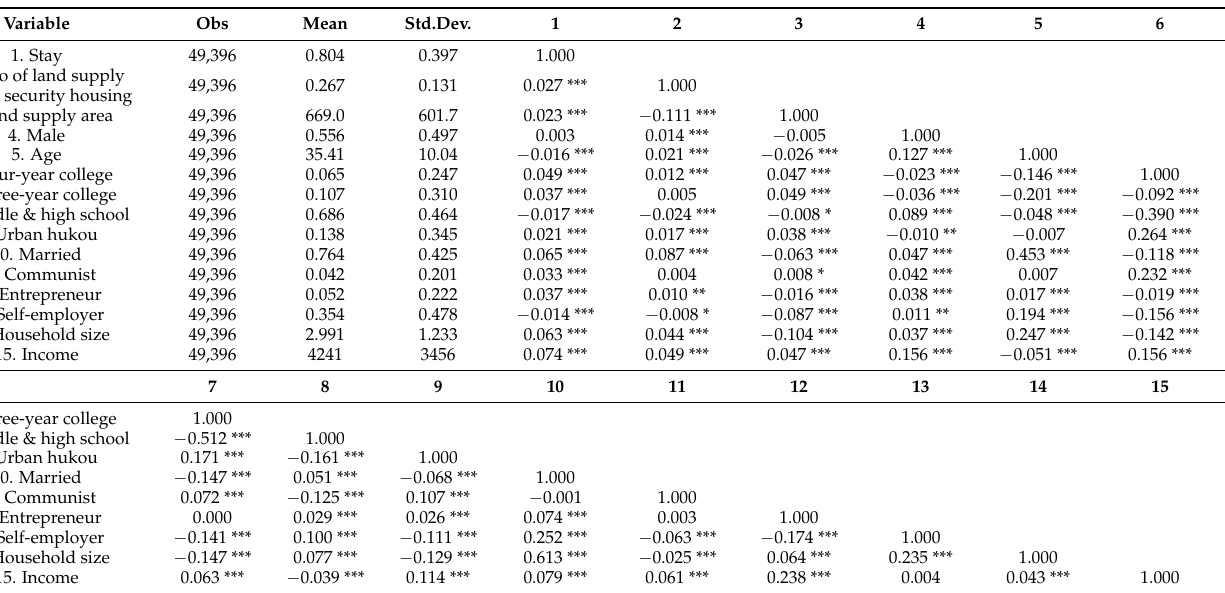
Table 1. Summary statistics and correlation